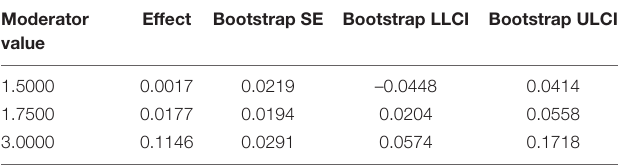
TABLE 6 | Direct effect.